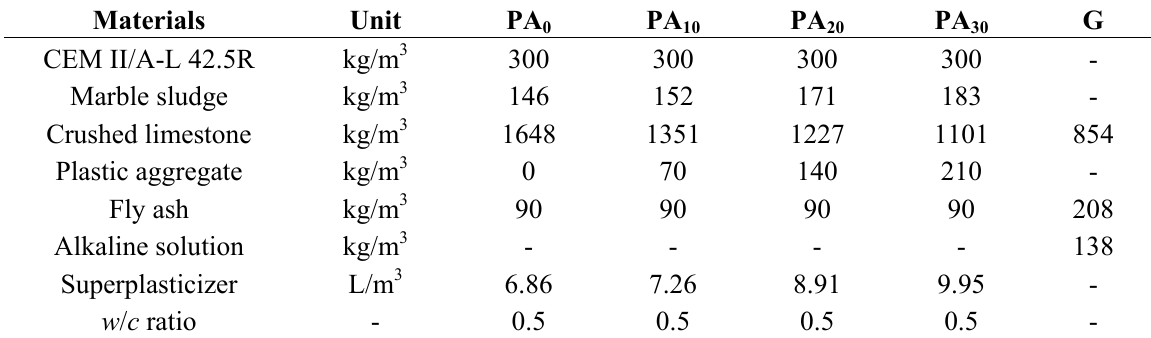
Table 3. Mix proportions for concrete